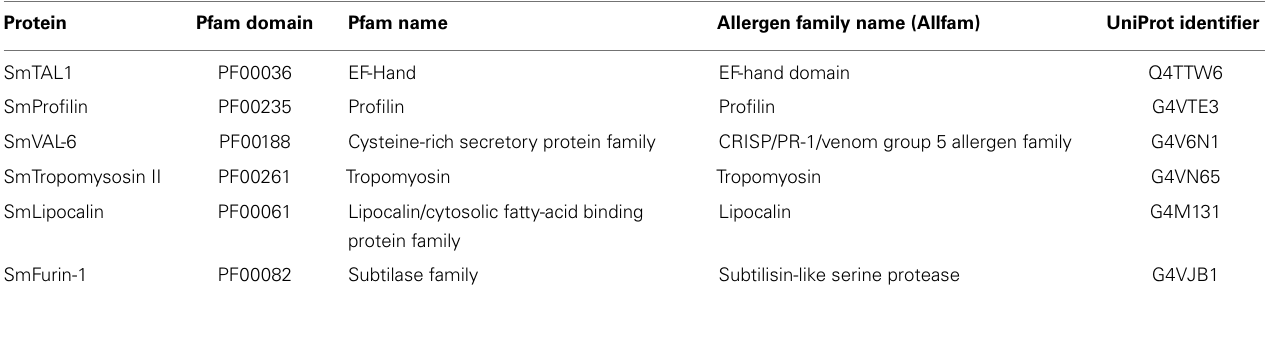
Table 1 | Schistosoma mansoni antigens with functional sequence identity to abundant allergens .